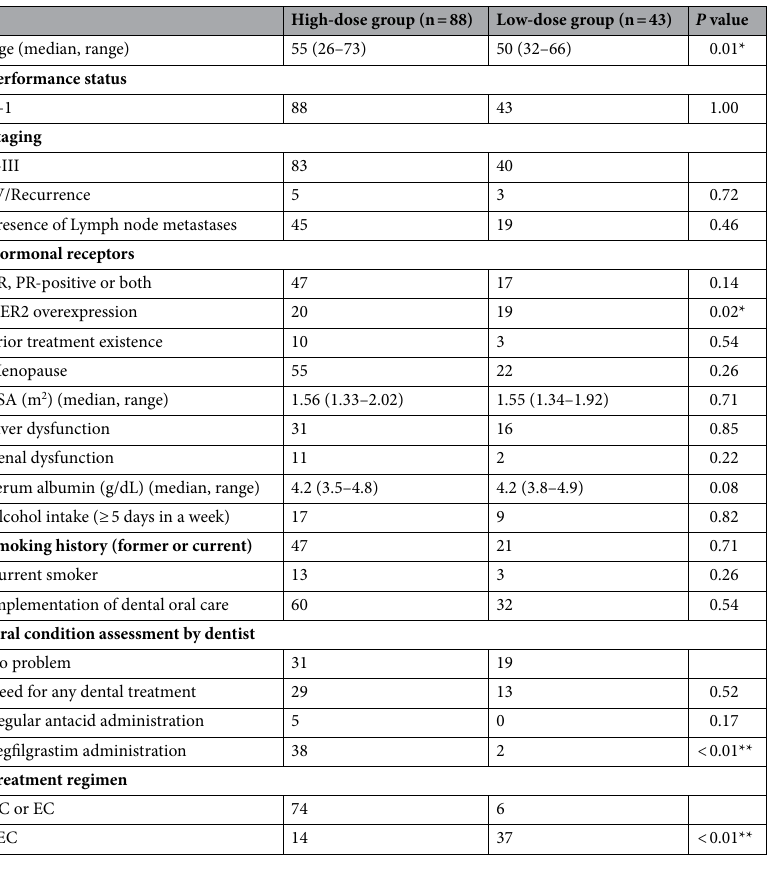
Table 1. Patient characteristics. Liver dysfunction: grade 1 or higher aspartate aminotransferase, alanine aminotransferase, and total bilirubin levels. Renal dysfunction: grade 1 or higher serum creatinine elevation. Antacids include proton pump inhibitors and histamine type 2 receptor antagonists. ER estrogen receptor, PR progesterone receptor, HER2 human epidermal growth factor receptor 2, BSA body surface area, AC doxorubicin (60 mg/m 2 ) + cyclophosphamide (600 mg/m 2 ), EC epirubicin (90 mg/m 2 ) + cyclophosphamide (600 mg/m 2 ), FEC epirubicin (100 mg/m 2 ) + cyclophosphamide (500 mg/m 2 ) + 5-fluorouracil (500 mg/m 2 ). * P < 0.05. ** P <